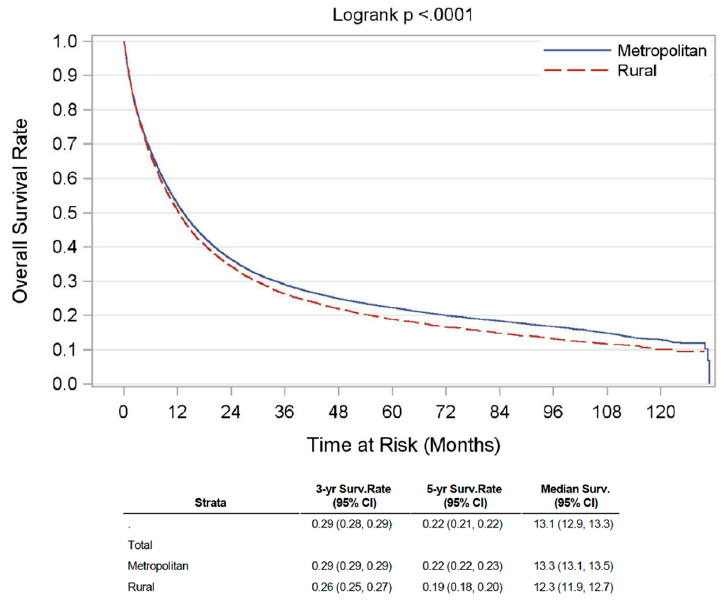
Figure 1. Unadjusted Kaplan–Meier OS curve for gastric adenocarcinoma patients in rural versus metropolitan region.